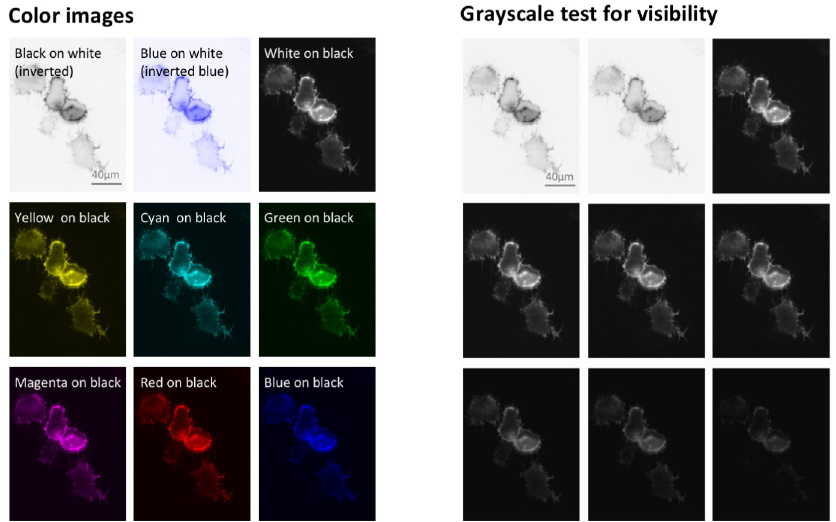
Fig 6. Visibility of colors/hues differs and depends on the background color. The best contrast is achieved with grayscale images or dark hues on a light background (first row). Dark color hues, such as red and blue, on a dark background (last row), are least visible. Visibility can be tested with mock grayscale. Images show actin filaments in Dictyostelium discoideum (LifeAct-GFP). All images have the same scale. GFP, green fluorescent